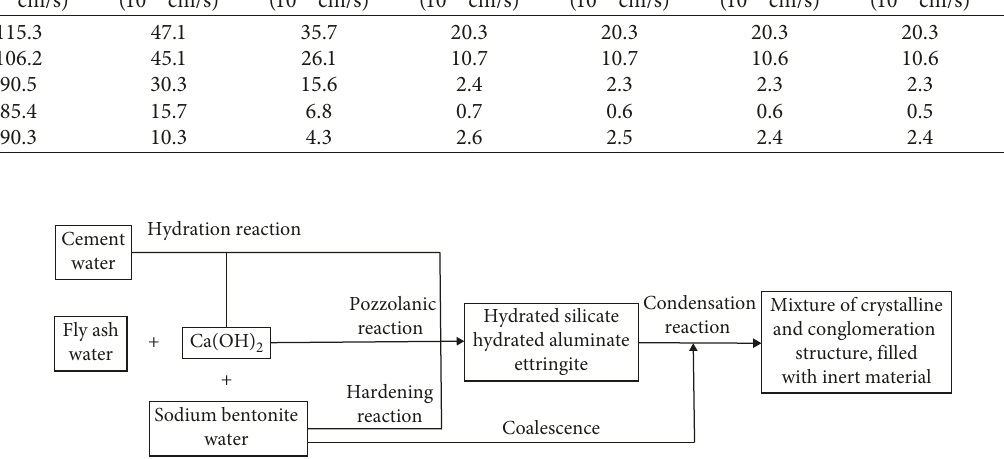
Figure 6: Reaction procedures during slurry preparation.